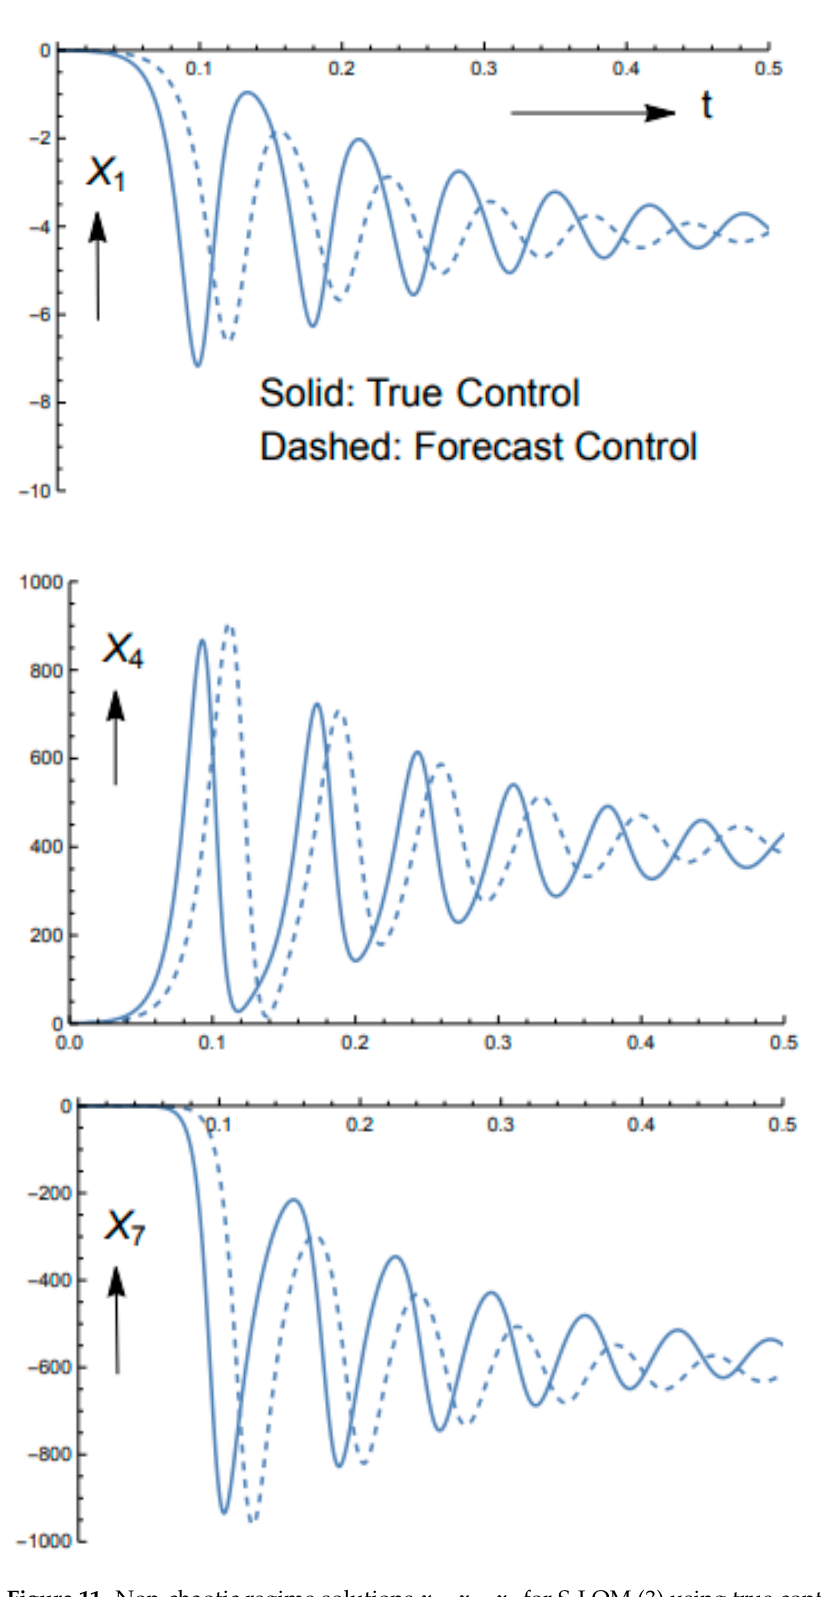
Figure 12. S-LOM (3) forecast sensitivity of 𝑥 (cid:2872) and 𝑥 (cid:2875) to controls for the non-chaotic regime. Results from the data assimilation experiment are shown in Table 3. The data assim- ilation process converges to (𝜆, 𝜎) = (13.8, 4.8) in 4 iterations. The cost function is re- duced 9 orders of magnitude. The cost function for this case is shown in Figure 13. The converged values of control shown in Table 3 are consistent with this cost function’s min- imum. In a test that changed observation time from 𝑡 (cid:3042)(cid:3029)(cid:3046) = 0.16 to t = 0.10, FSM did not con- verge to an optimal state. Instead, after a single iteration the result was (𝜆, 𝜎) = (−46.3, 26.8) , unreasonable physically.